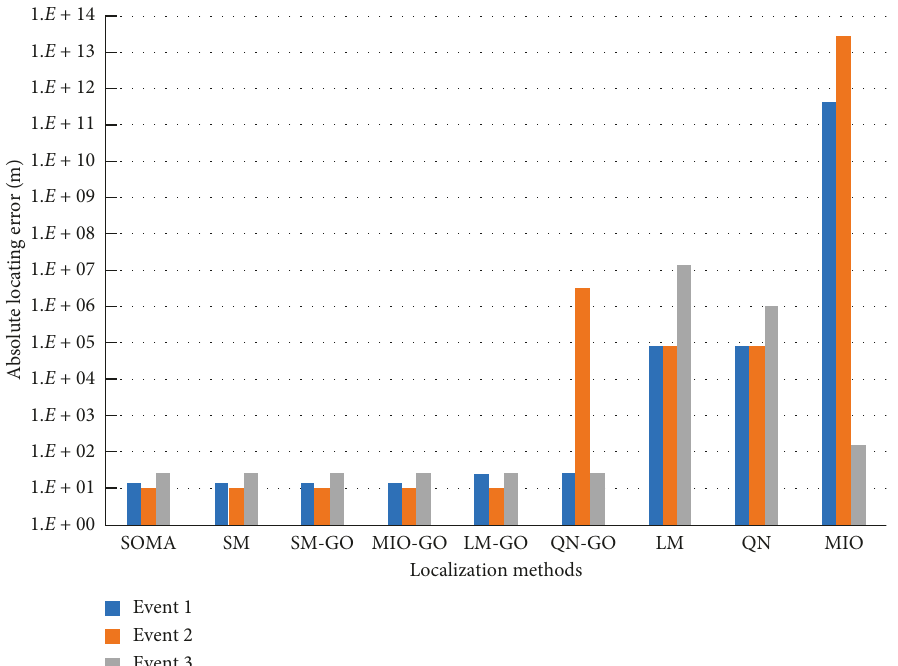
Figure 2: Charts of location results using different methods for three events in Dongguashan copper mine (from